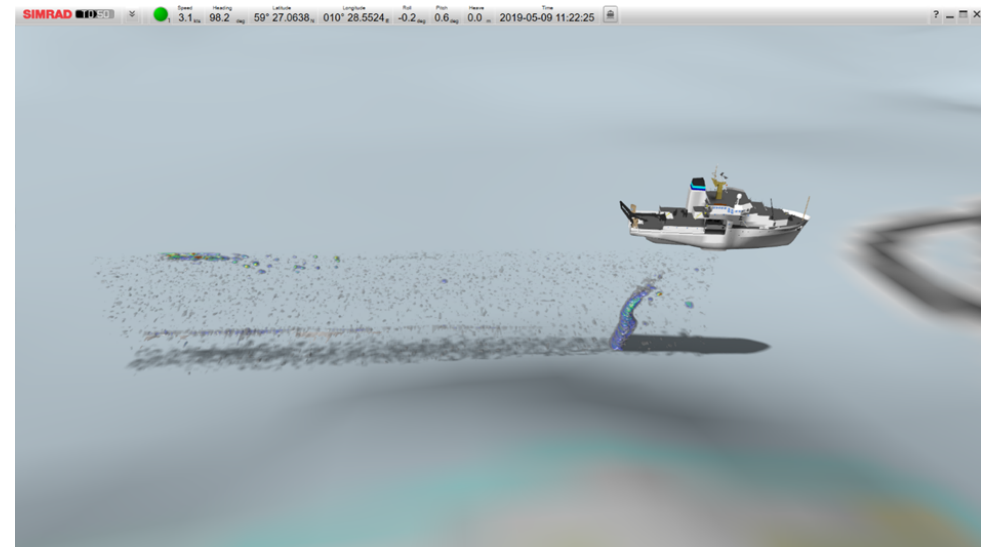
Figure 3. Data acquisition using the Simrad Echo research vessel during the ACT4storage controlled release experiment. The seep visible in the image is the same as in Figure 2, here detected using the Simrad ME70 MBES. The release rate is 1.3 liters/minute of pure gaseous CO 2